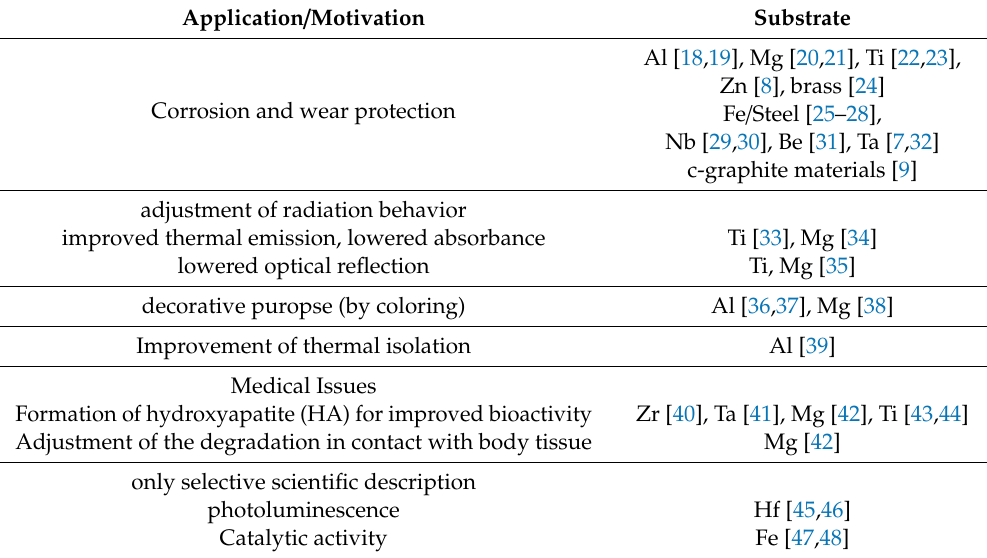
Table 1. Selected applications and examples for the PEO of di ff erent